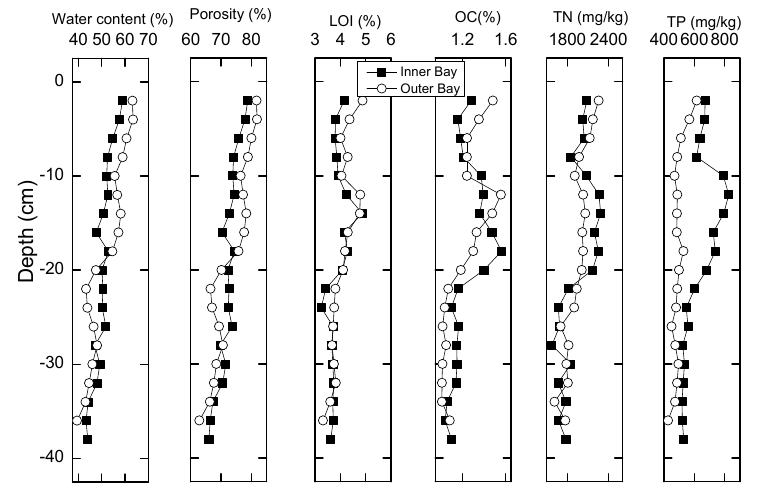
Figure 2. Vertical profiles of selected physicochemical characteristics of sediments.